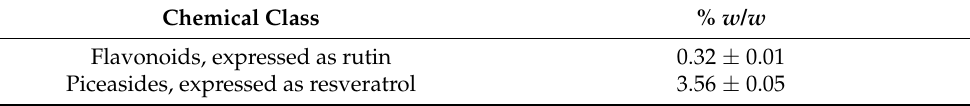
Figure 5. Proposed fragmentation pattern of piceaside with dioxanic group. Table 4. Quantity of flavonoids and piceasides in bark of Norway spruce methanolic extract. Chemical Class % w / w Flavonoids, expressed as rutin Piceasides, expressed as